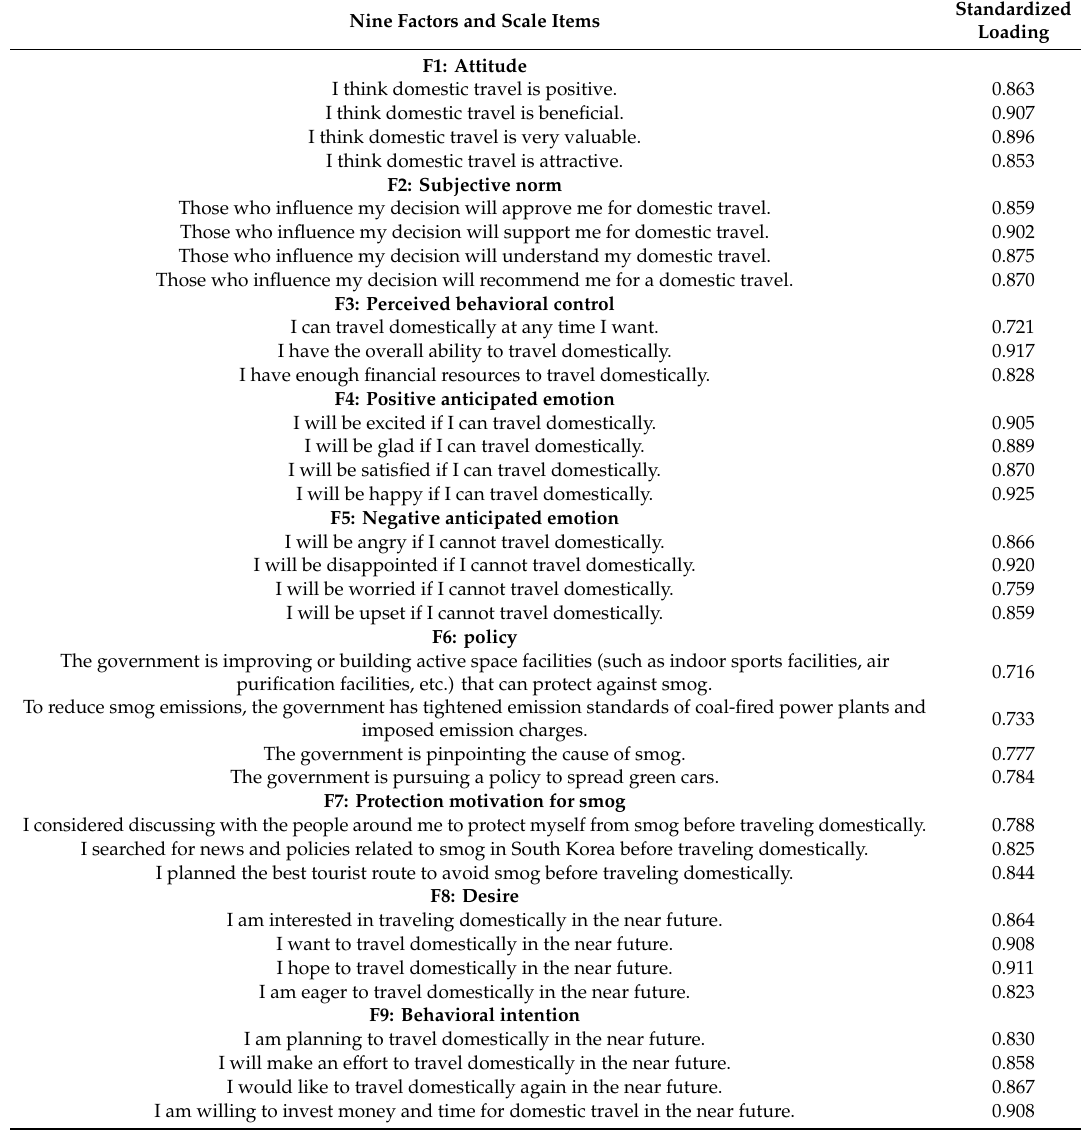
Table 2. Confirmatory factor analysis and factor